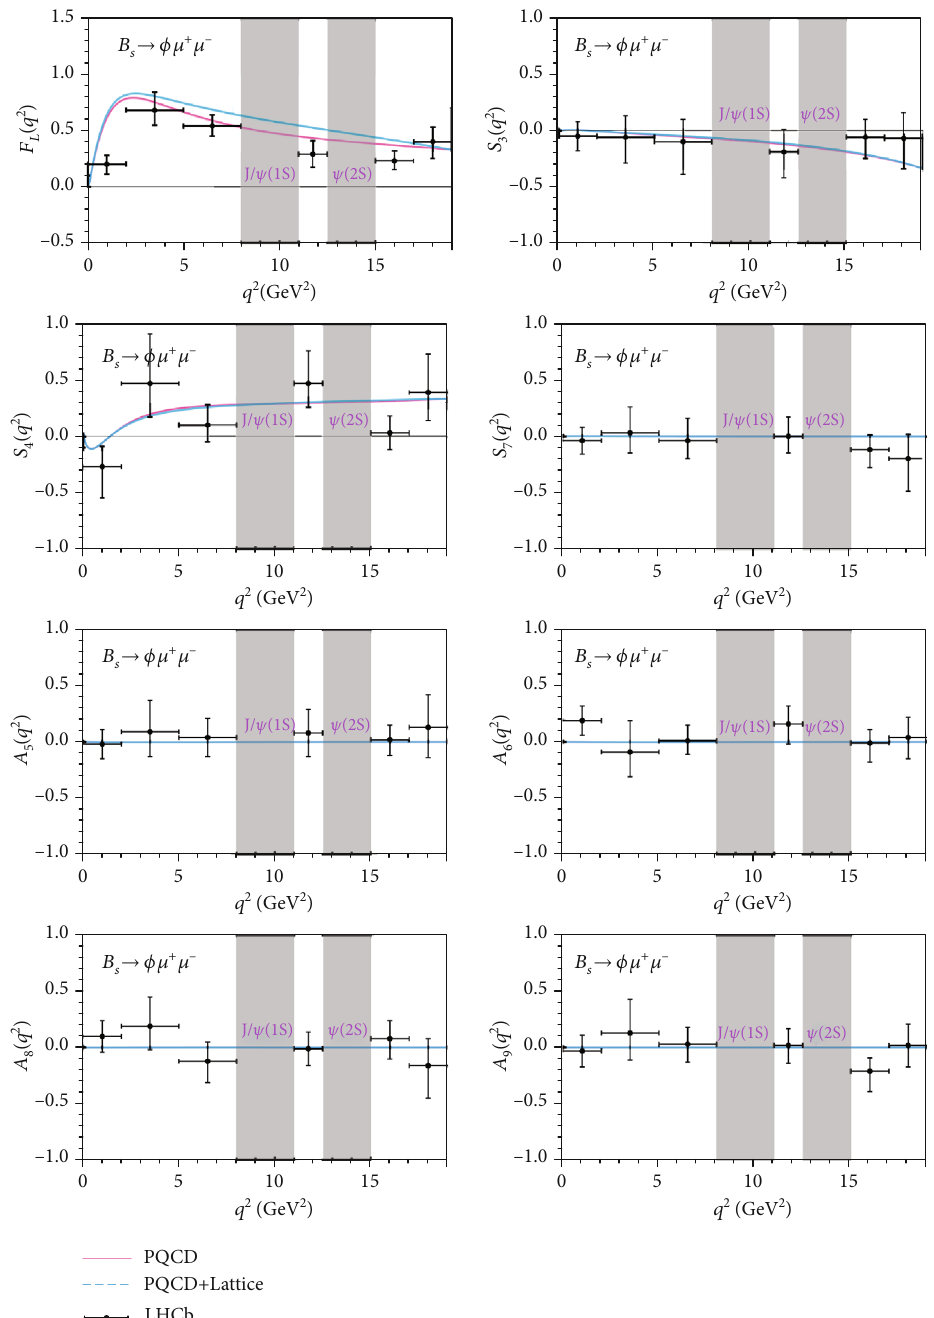
ð q 2 Þ , S ð q 2 Þ , and A ð q 2 Þ for the decay B ⟶ ϕμ + μ − in 3,4,7 5,6,8,9 L s